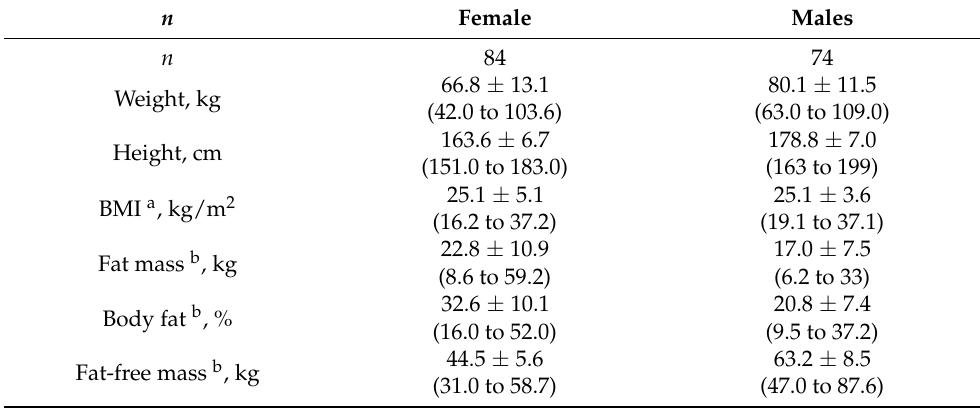
Table 1. Physical characteristics of participants. Values are mean ± SD (range of